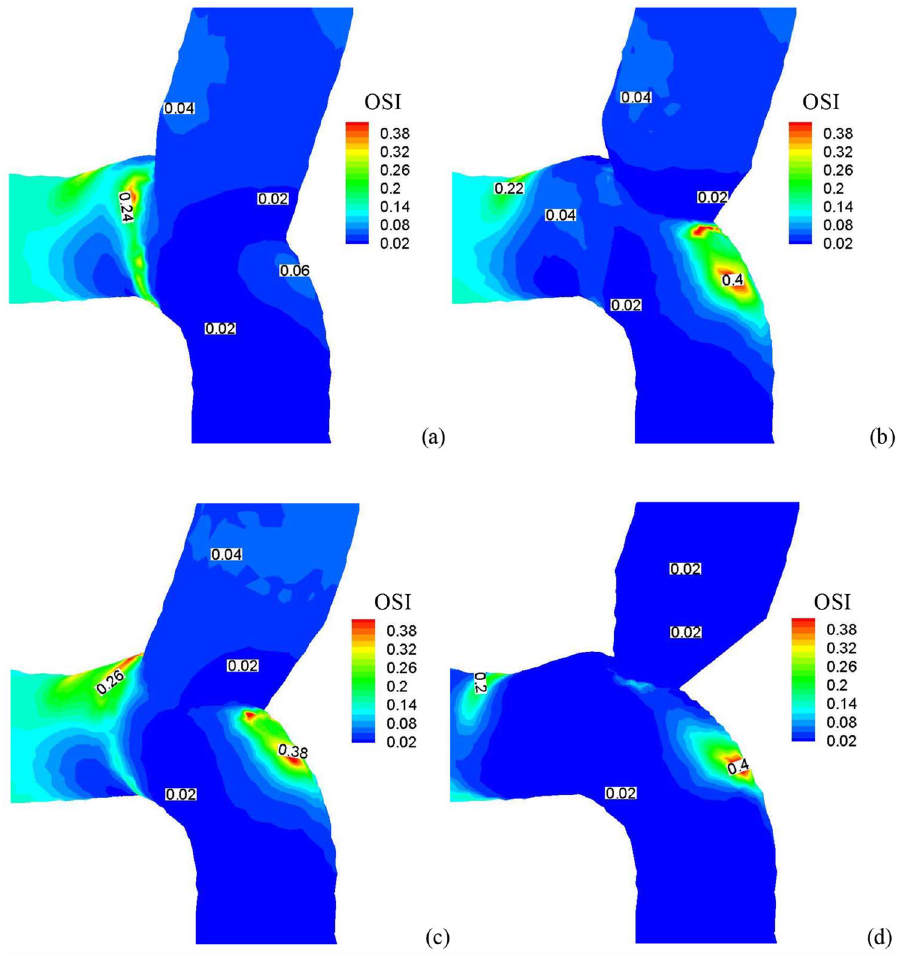
Figure 5. The distribution of OSI at the anastomosis between SVG and coronary artery in correspondence with Fig. 4.